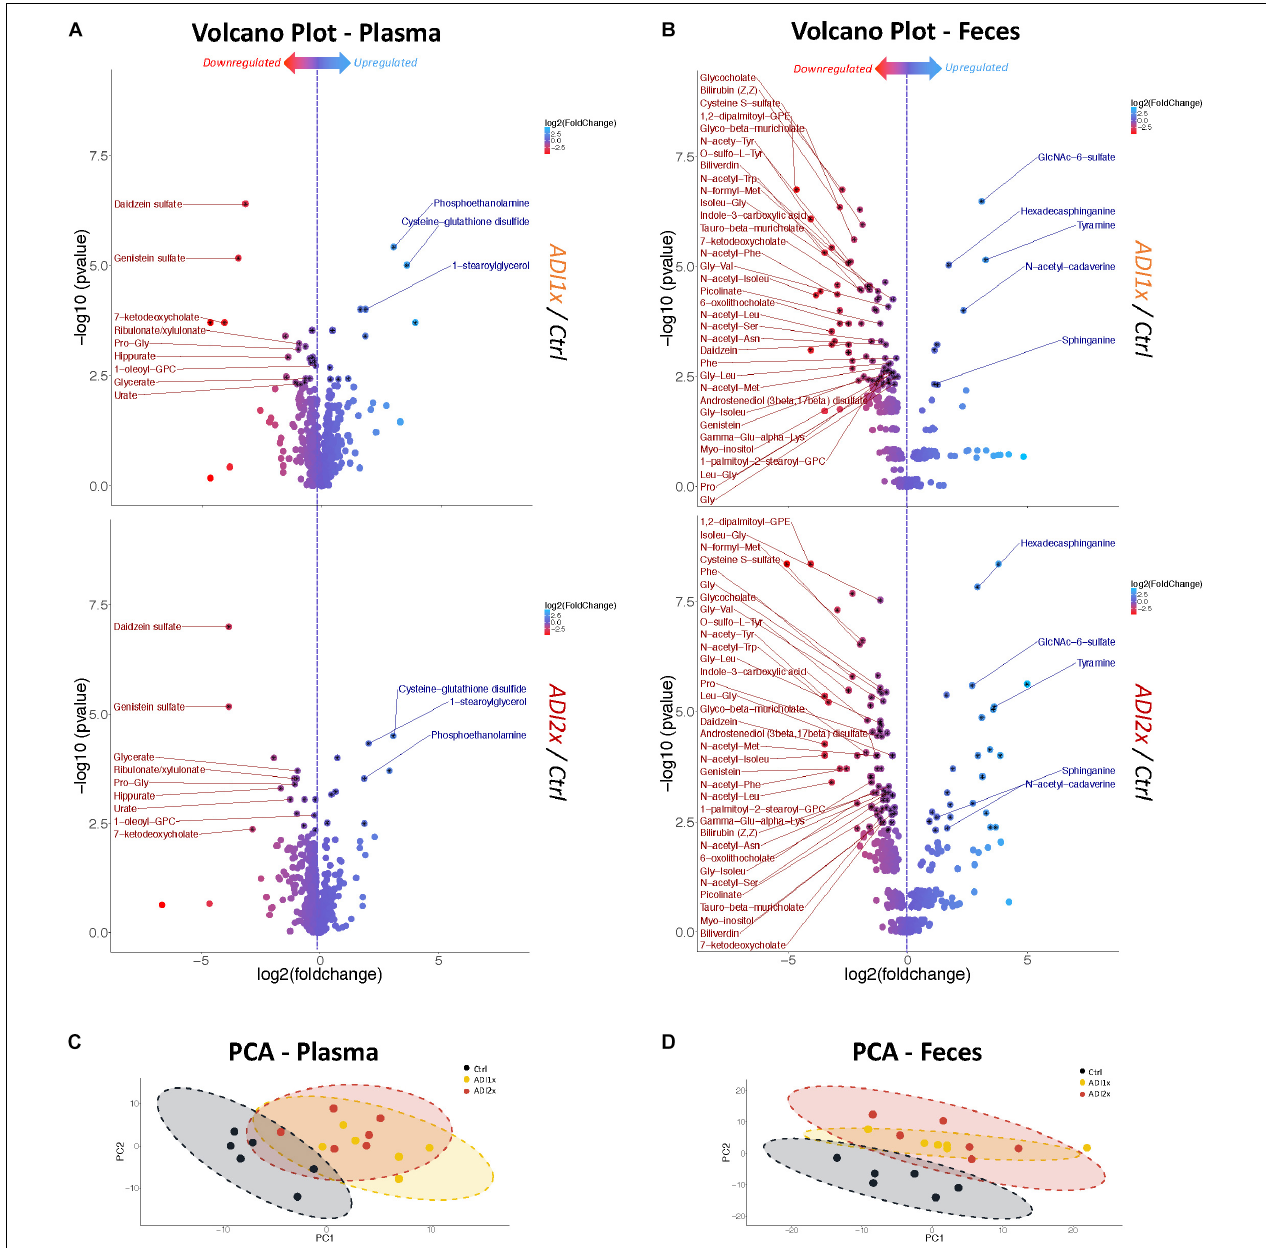
FIGURE 2 | Feces and plasma samples highlight major metabolic deregulation in pups born to NNS-exposed mothers. (A,B) Volcano plot of metabolites in plasma and feces for ADI1x (top panel) and ADI2x (bottom panel) compared to control group ( n = 6). Significant metabolites ( p < = 0.005) are pointed to with a black asterisk. Only highly significant deregulated metabolites ( p < = 0.005) in both ADI1x and ADI2x in plasma or feces are labeled on volcano plots (ANOVA). (C,D) Principal component analysis (PCA) for plasma and fecal metabolites. Ellipses represent Student’s t -distribution ( n =